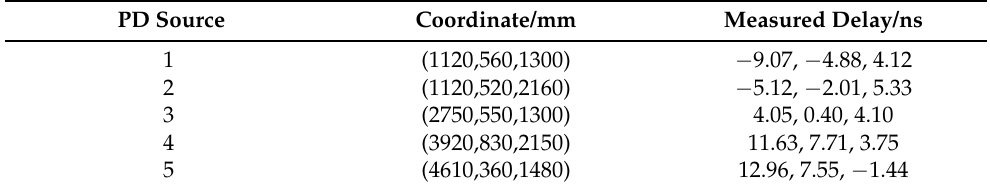
Figure 7. PD localization diagram. Table 3. Standard test functions.